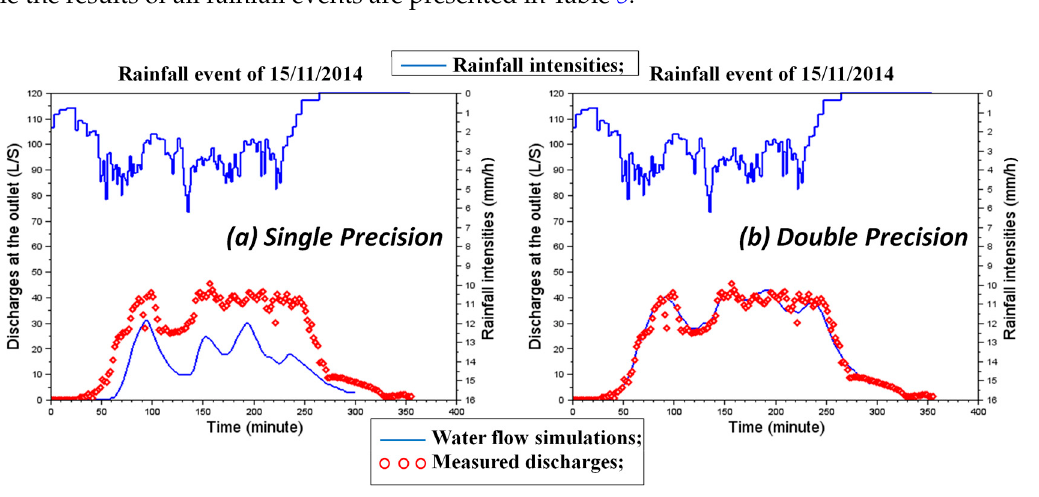
Figure 8. Change of the hydrograph due to the change from ( a ) single ‐ precision to ( b ) double ‐ precision floating ‐ point format of the source code. The simulated discharges at the outlet (solid blue line) are compared with the measured data (red circles). Rainfall is plotted on the upper part. Table 5. Influence of numerical precision of the source codes on water flow at the outlet of the sewer system.